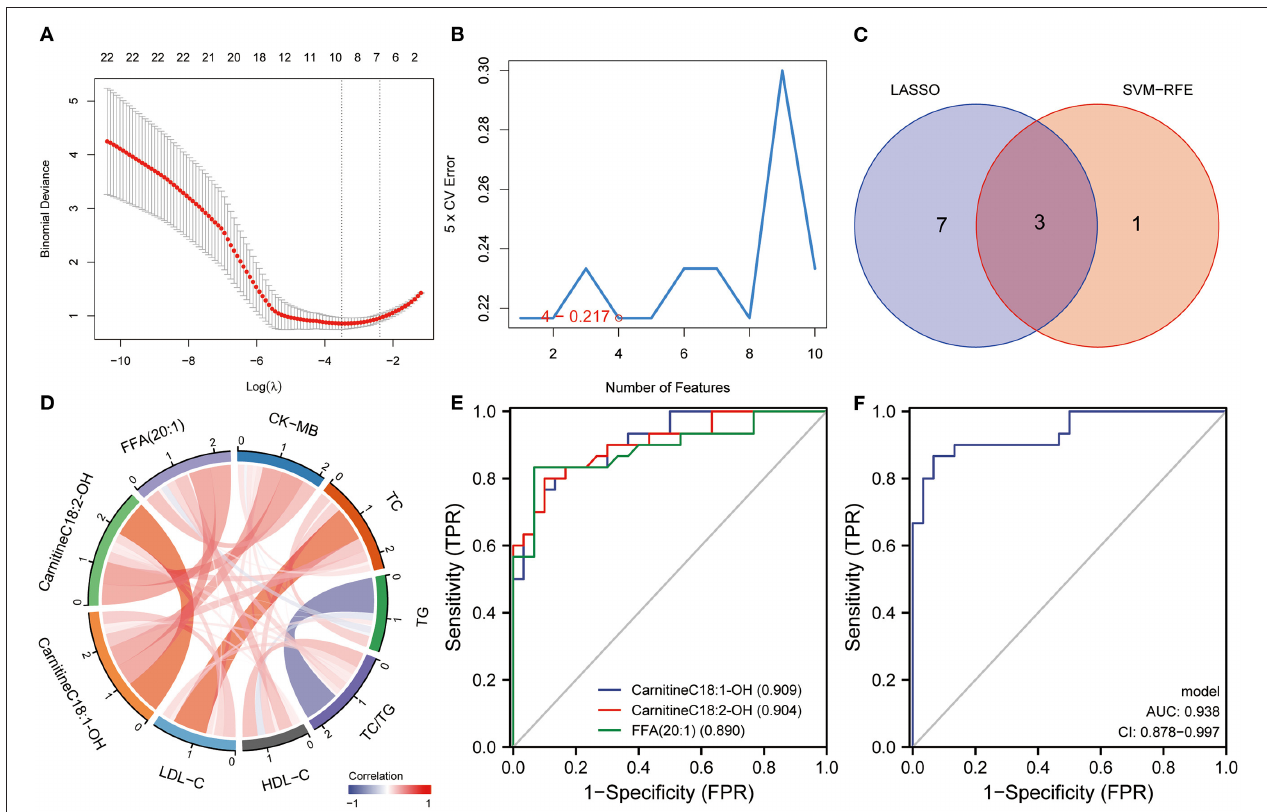
FIGURE 5 | Identification of lipid diagnostic biomarkers. (A) LASSO and (B) SVM-RFE algorithms in the discovery set. (C) Veen diagram shows the lipid biomarkers selected by the LASSO and SVM-RFE algorithms. (D) Correlation analysis between lipid biomarkers and routine clinical indexes. (E) The diagnostic performance of lipid biomarkers in distinguishing AMI from UA was evaluated by ROC analysis in discovery set. (F) The diagnostic performance of diagnostic model in distinguishing AMI from UA was evaluated by ROC analysis in discovery